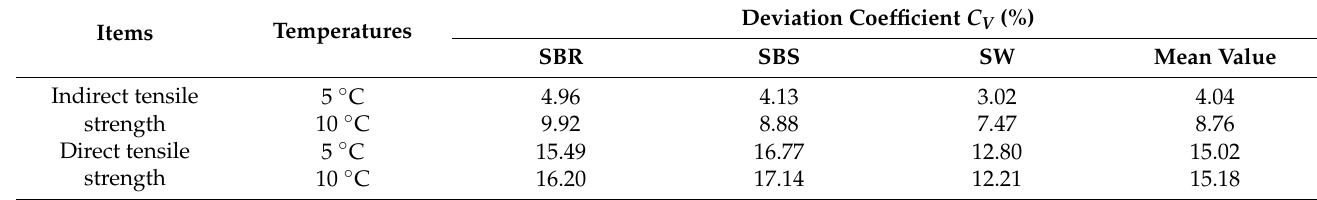
Table 2. Strength deviation coefficient of the two experimental